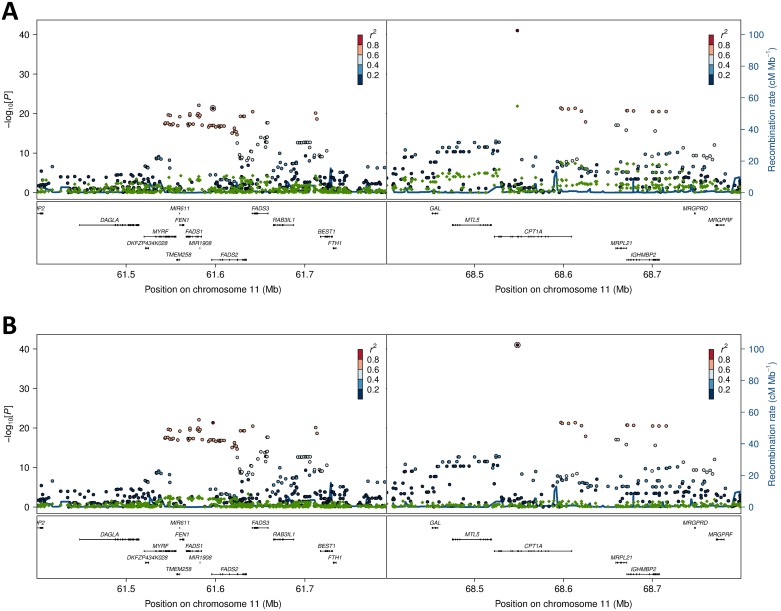
Association and conditional plot combined for the FADS2 and CPT1A loci with erythrocyte membrane 11-eicosenoic acid (20:1 ω-9).The association results of the unconditional analysis are colored according to the LD, which was calculated separately for the two regions in each plot for the candidate SNPs, rs174570 and rs80356779, respectively. The p-values are based on imputation data. Green dots represent the results of the conditional analyses, and the circle denotes the SNP conditioned on A) rs174570 and B) rs80356779.